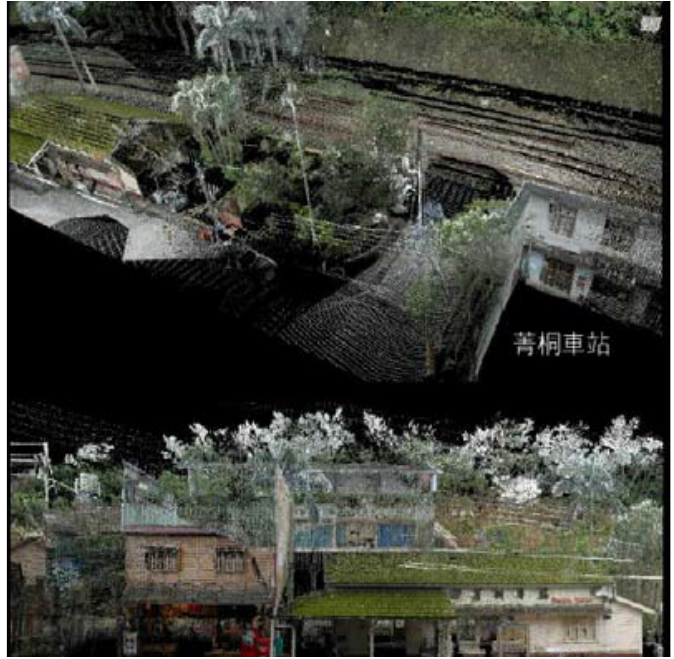
Fig. 1. Point clouds of Jing-Tong Train Station ( Source: H.Cheng et al.